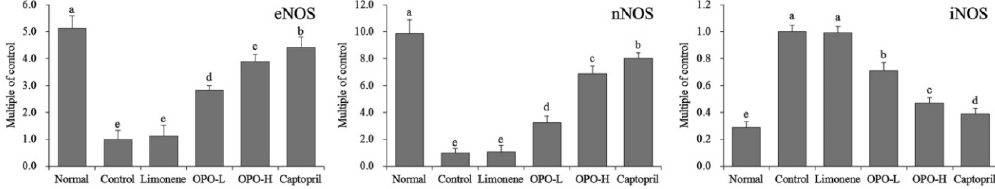
Figure 7. mRNA expression levels of nNOS, eNOS and iNOS in rat myocardial tissue. For each group, n = 10 rats. a–e Bars with different letters in the chart are significantly different ( p < 0.05) according to Duncan’s multiple range test, and the same letter indicates that the values are not significantly different. OPO-L, orange peel oil low dose, 5 mL/kg bodyweight (bw); OPO-H, orange peel oil high dose, 10 mL/kg bw; captopril, 15.6 mg/kg bw; and limonene, 10 mL/kg bw.